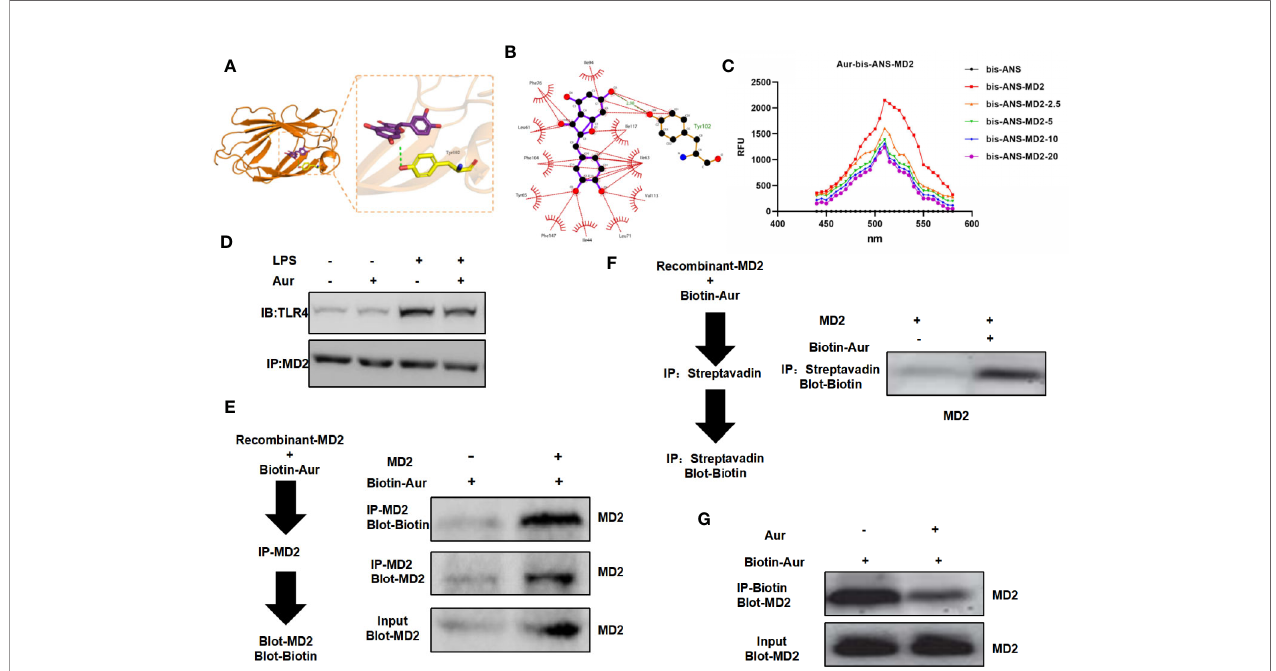
FIGURE 4 | Validation of the targeted binding correlation between Aur and MD2 protein. (A, B) : The virtual docking of the binding between Aur and MD2. (C) : A bis-ANS assay showed that Aur could decrease the fl uorescence intensity in a dose-dependent manner. (D) : A co-IP assay showed no signi fi cant binding between Aur and TLR4, but that Aur could bind with MD2. (E, F) : A pull-down assay revealed that Aur could bind with MD2. (G) : A competitive binding assay demonstrated that large doses of Aur could compete with Biotin-Aur and decrease the binding level of